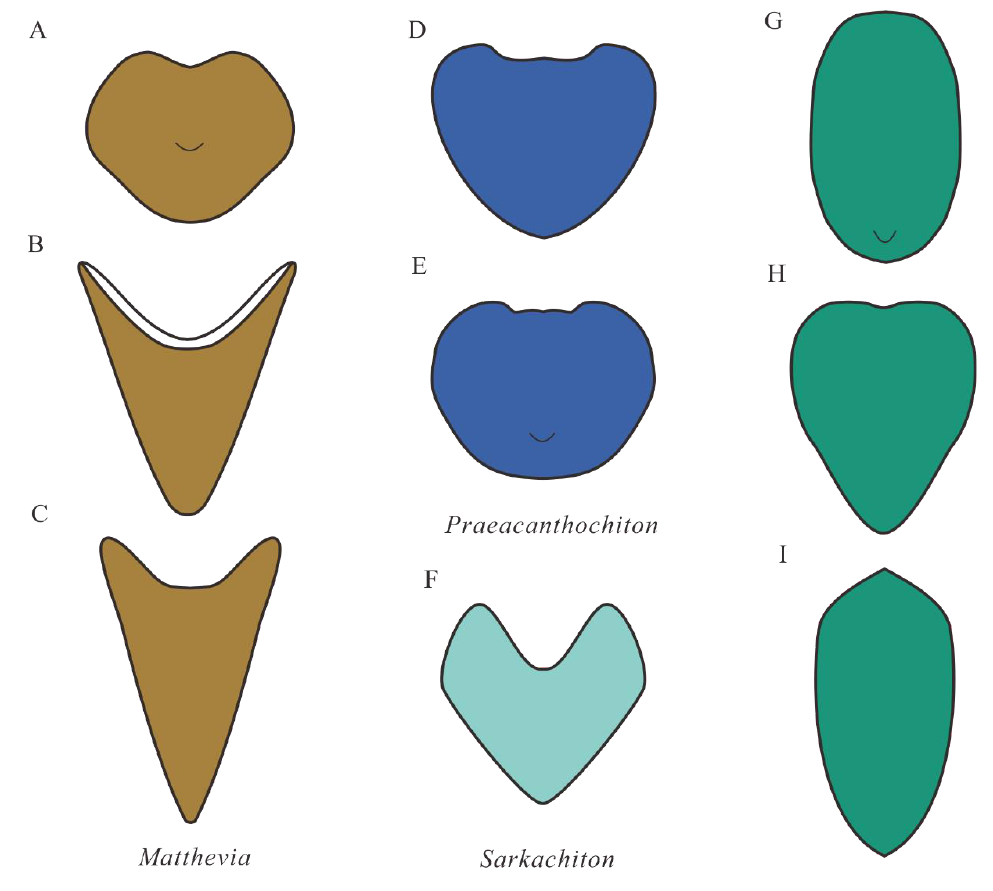
Figure 8. Simple outline of early Palaeozoic Polyplacophorans. ( A – C ) Matthevia , dorsal view, head valve, intermediate valve, and tail valve, respectively (modified from explanation of plate 1 in Runnegar et al. [50]). ( D , E ) Preacanthochiton , dorsal view, intermediate valve, and tail valve, respectively (modified from explanation of plate 2 in Runnegar et al. [50]). ( F ) Sarkachiton , dorsal view, intermediate valve (modified from plate 53 in Dzik [64]). ( G – I ) Chelodes , dorsal view, head valve, intermediate valve, and tail valve, respectively (modified from text-Figure 4 in Cherns [58], Figure 2 in Cherns [51], and explanation of plate 2 in Runnegar et al. [50]).